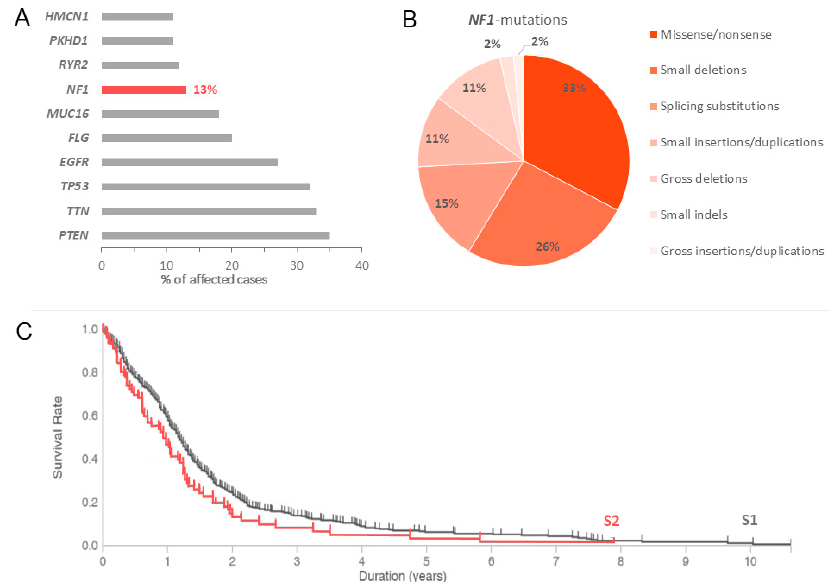
Figure 5. NF1 mutations in glioblastoma cases (not associated with NF1). ( A , B ): Distribution of most frequently mutated genes in glioblastoma and spectrum of mutations. ( C ): Overall survival plot of patients with NF1 mutated glioblastoma (S2; n = 79) compared with NF1 wild-type cases (S1; n = 516). Log-Rank test p -value 0.017. Data were derived from the Genomic Data Commons Data Portal (TCGA database).